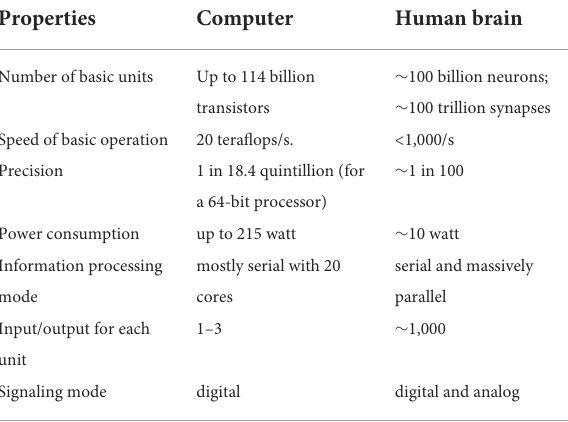
TABLE 1 Comparing (traditional) computers and